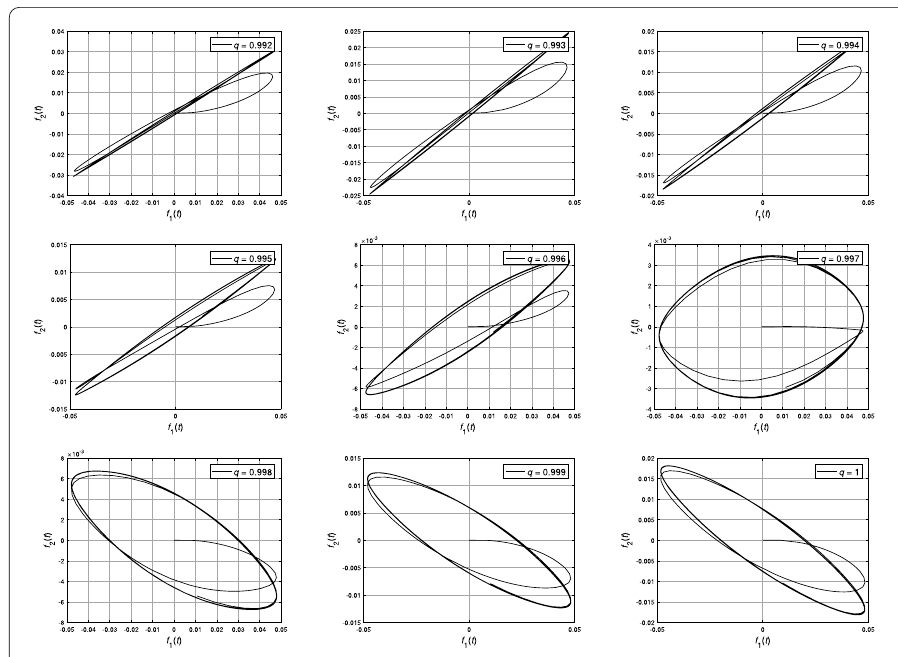
Figure 9 The phase-portraits of the controlled system (35) for q = 0.992,0.993,0.994,0.995,0.996,0.997,